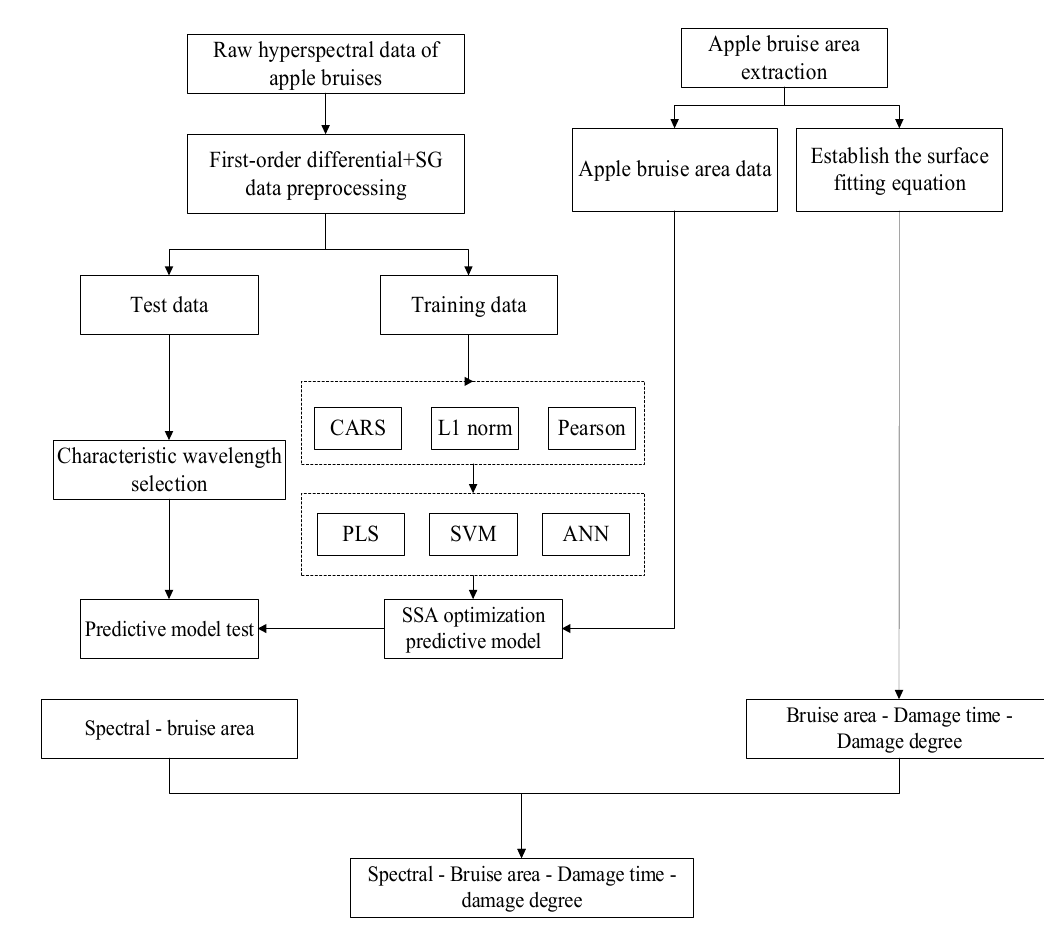
Figure 12. Flow chart of fruit bruise area prediction.